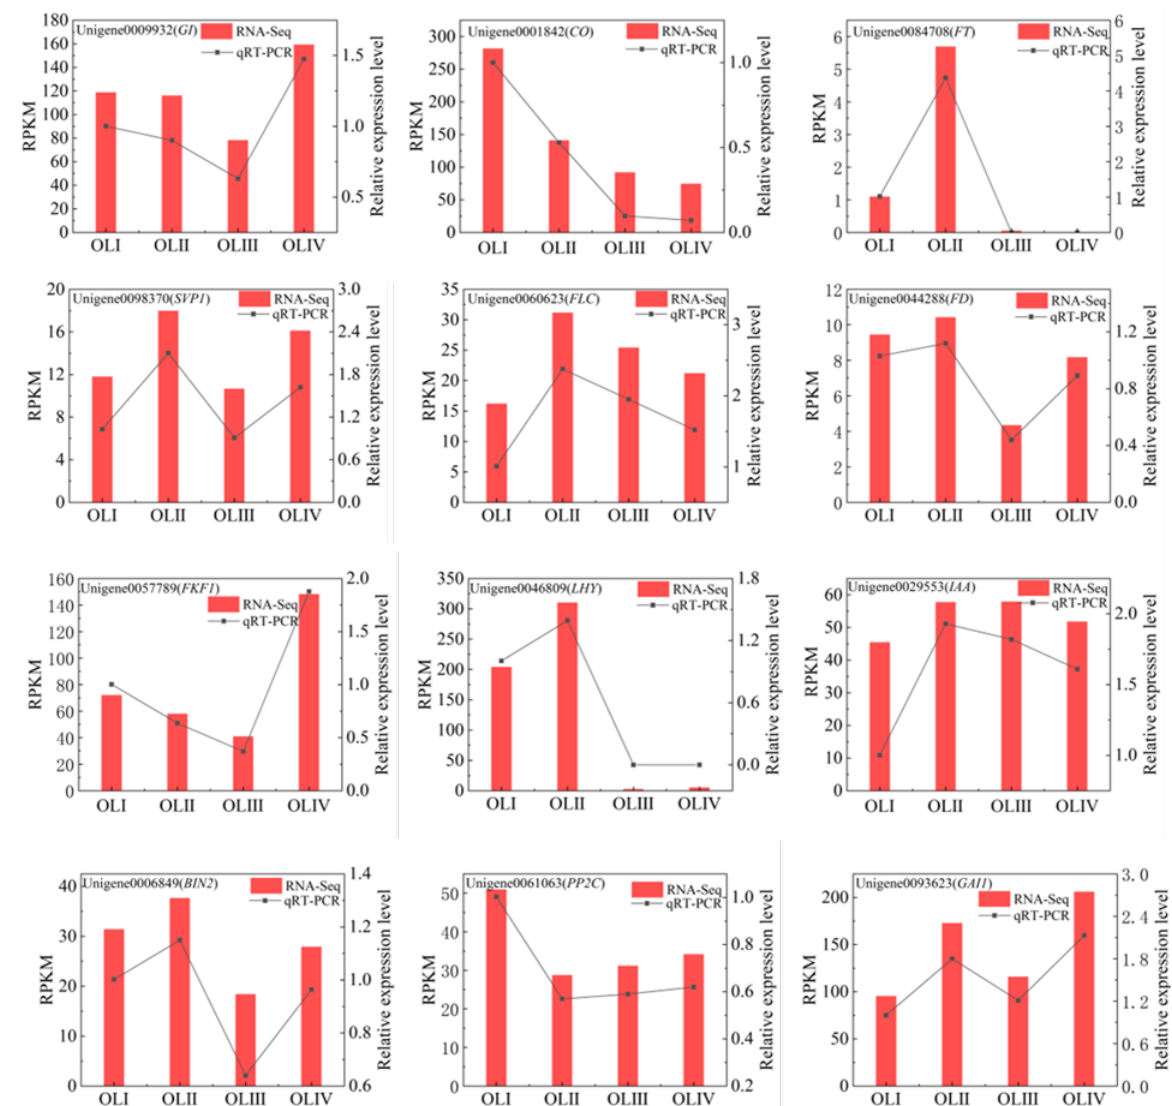
Figure 9. The comparison of the expression levels of 12 DEGs identified related to flowering, rhythm, and hormone between RNA-Seq and qRT-PCR analyses from old leaves at different developmental stages during floral transition. CoTUB1 is used as internal control.